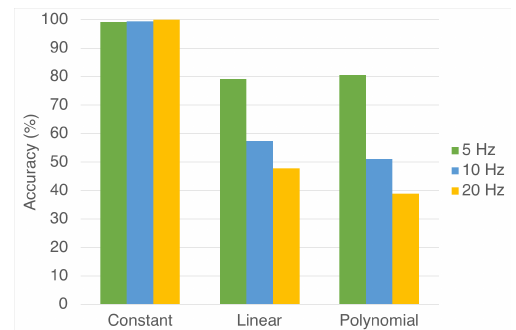
Figure 6. Classification accuracy of the SVMs as a function of the discretization step of the speed range.